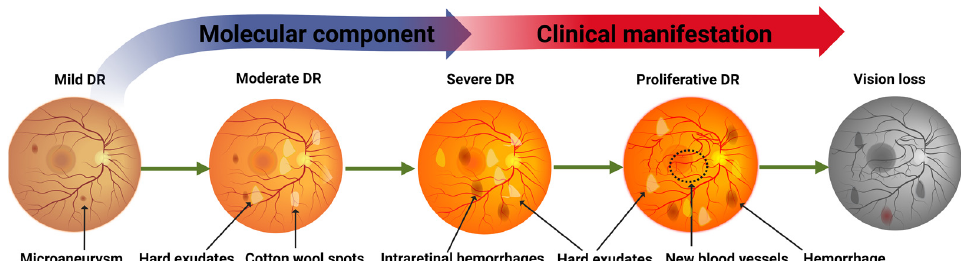
Figure 1. DR progression from mild to proliferative to vision loss. Also represented are the starting points and the increasing progression of the molecular and clinical components of DR with typical lesions.